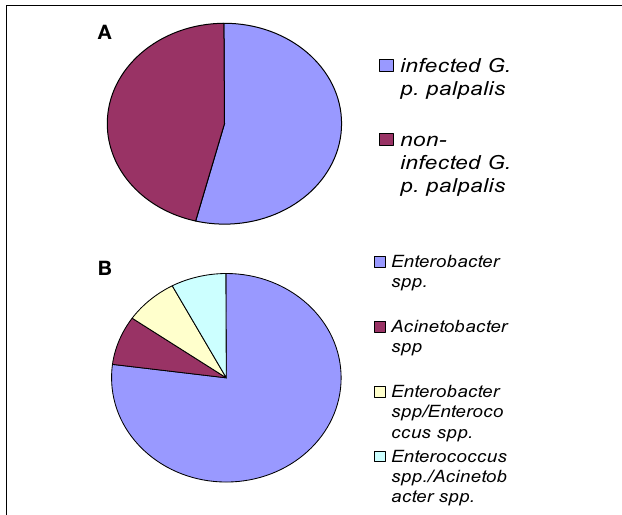
FIGURE 2 | G. palpalis palpalis infections in the Maria Teresa focus in Angola according to Geiger et al. (2009). (A) Prevalence of infection in tsetse flies; (B) frequency of occurrence for each infection type. “Multiple” names indicate the occurrence of a mixed infection.